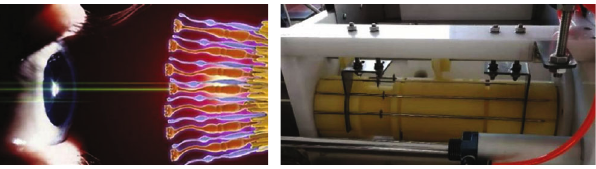
Figure 9: The biological prototype of the upper skewer